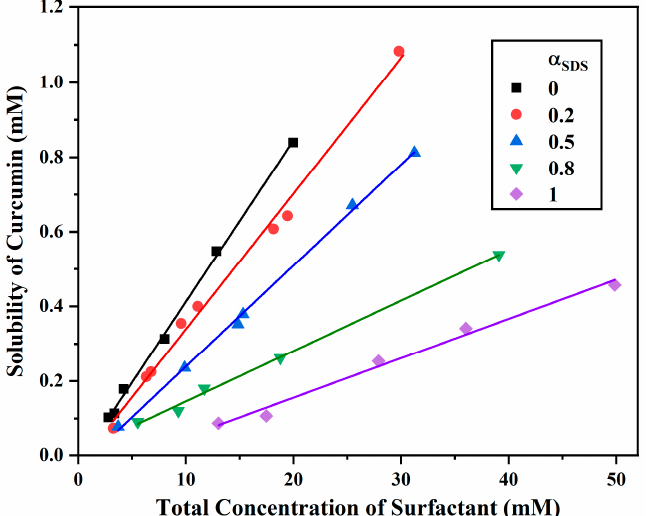
Figure 1. The apparent solubility of curcumin in SDS/Brij35 mixed surfactant systems with different α SDS as a function of C T .